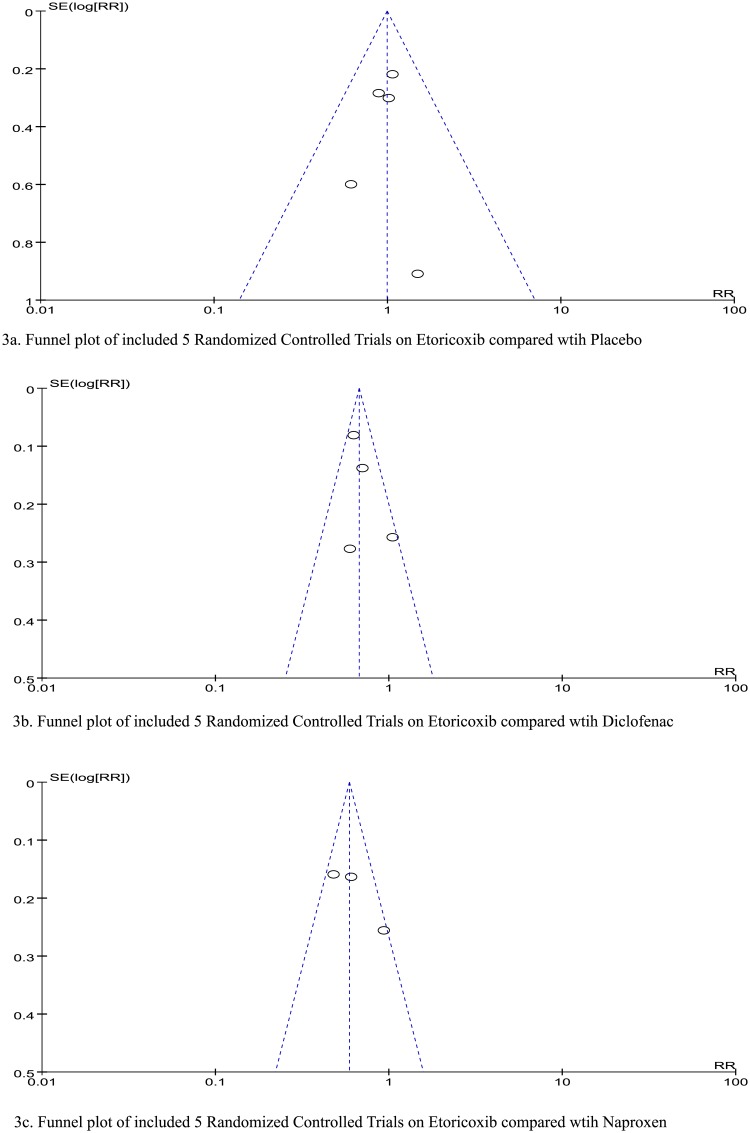
Funnel plot of publication bias for etoricoxib compared with placebo, diclofenac, and naproxen.